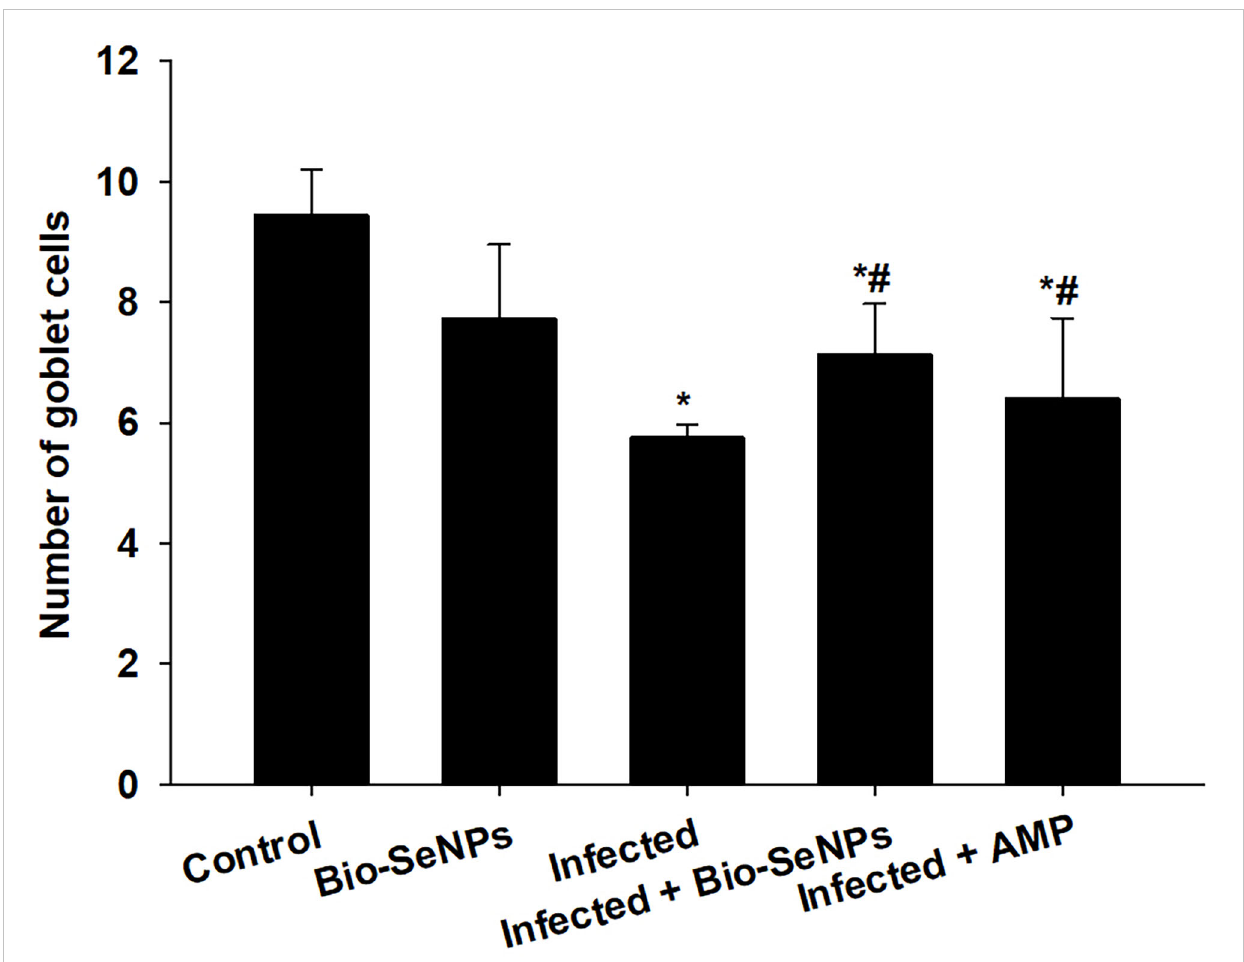
FIGURE 7 Changes in the number of jejunal goblet cells in the control group, infected group, treated group with Bio-SeNPs and the infected group treated with Bio-SeNPs and AMP. Values are means ± SEM. * signi fi cant change concerning the control group, # signi fi cant change concerning the infected